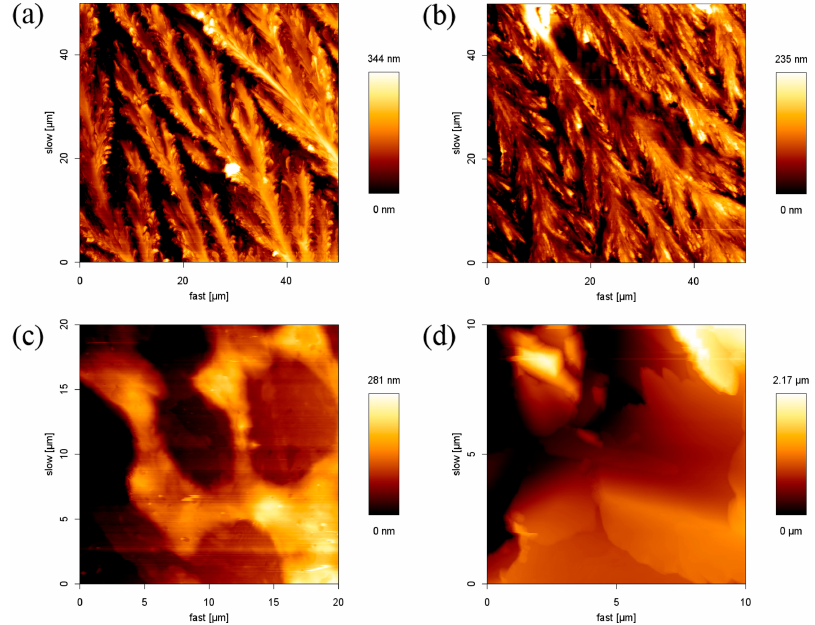
Figure 3. AFM images of SDS-inorganic salt aggregates on the surface of the glass: ( a ) SDS-NaCl; ( b ) SDS-KCl; ( c ) SDS-MgCl 2 ; and ( d ) SDS-CaCl 2 .